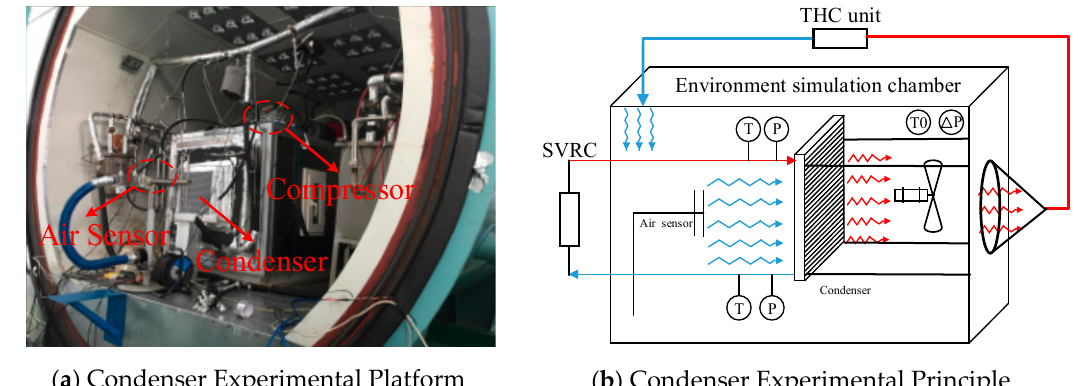
Figure 12. Experimental platform and its measurement points.